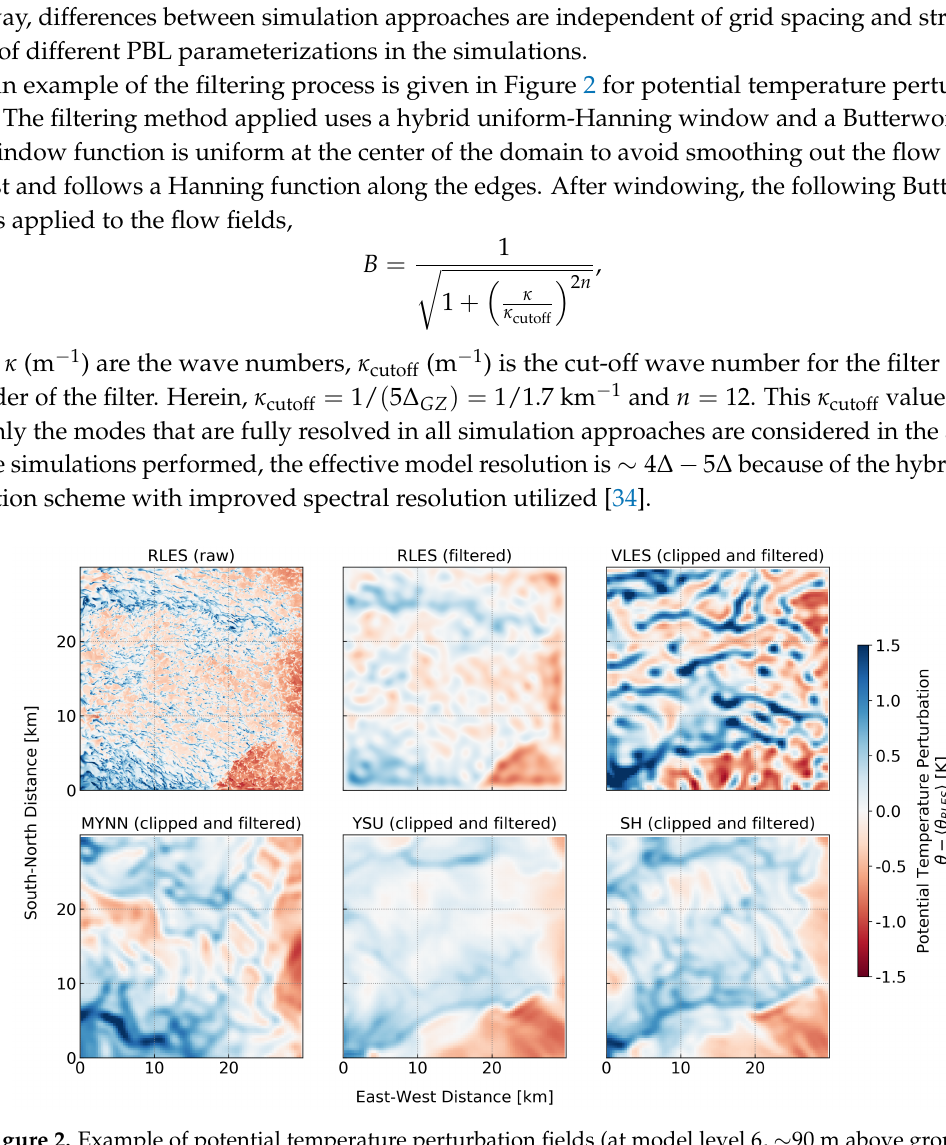
Figure 2. Example of potential temperature perturbation fields (at model level 6, ∼ 90 m above ground for this time) for each simulation approach. Data are valid for 28 March 2015, at 17:30 UTC (11:30 LT). RLES fields are shown before and after spatial filtering. Gray-zone fields (VLES, MYNN, YSU, SH) are shown after clipping and filtering. All fields are filtered at κ cutoff = 1/5 ∆ GZ ∼ 1/1700 m − 1